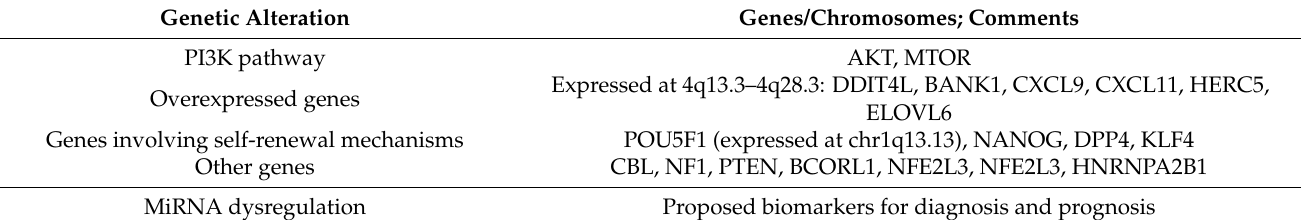
Abbreviations: CNS: central nervous system, KIT: transmembrane protein with tyrosine kinase activity; MAPK: mitogen-activated protein kinase; KRAS: V-Ki-Ras2 Kirsten Rat Sarcoma 2 Viral Oncogene Homolog; NRAS: Neuroblastoma RAS Viral (V-Ras) Oncogene Homolog;